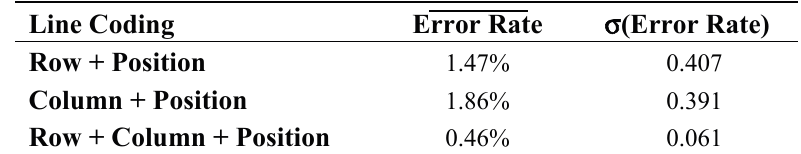
Table 10. Classification error rates for line coding based on length and position.